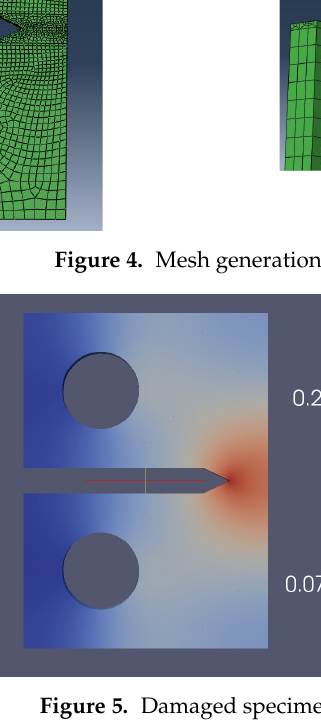
Figure 5. Damaged specimen.